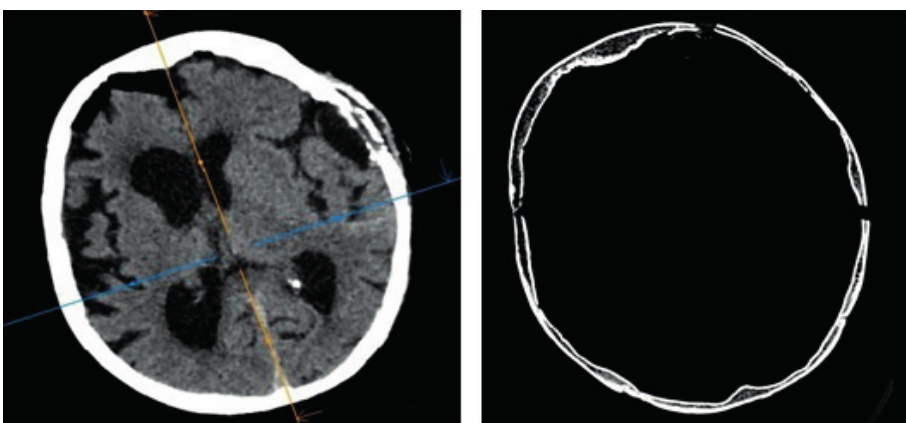
Fig. 3. Postoperative non-contrast brain CT scan (with bony window) seven days after surgery revealing removal of subdural mass with calcified membranes and good brain